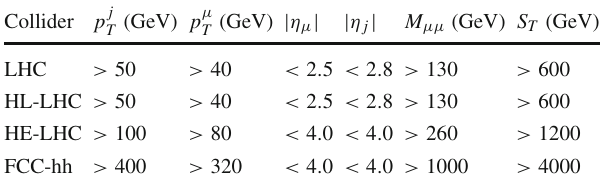
Table 4 Phase space cuts defining the signal regions in simulations of the 13 TeV LHC and future colliders. All cuts are applied in the analysis after parton showering and detector simulation